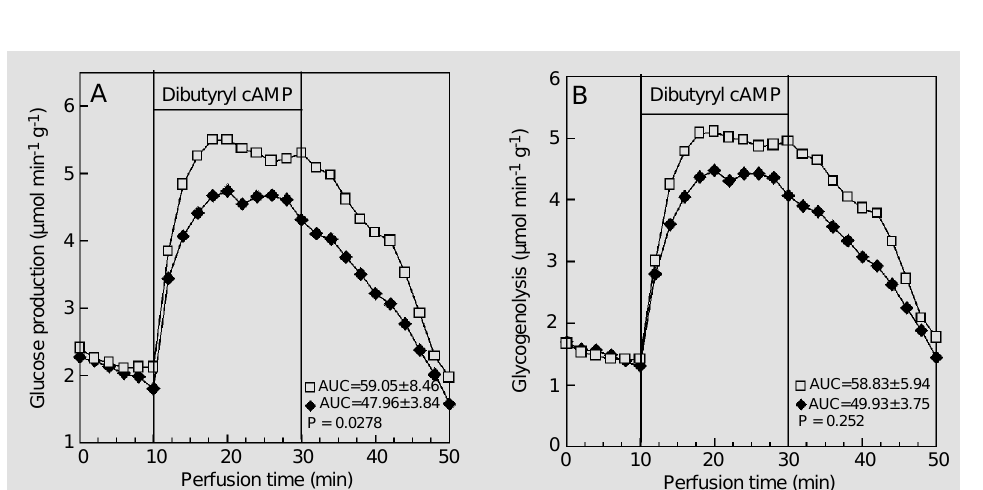
Figure 5 - Effect of dibutyryl cy- clic AMP (cAMP; 30 µM) on glu- cose production (panel A) and glycogenolysis (panel B). The data reported are the mean of 4 individual liver perfusion experi- ments performed 60 min after injection of saline (CN group, squares) or insulin (IN group, dia- monds). The livers were per- fused as described in Material and Methods. AUC = Area un- der the curve. The statistical test used was the unpaired Student t